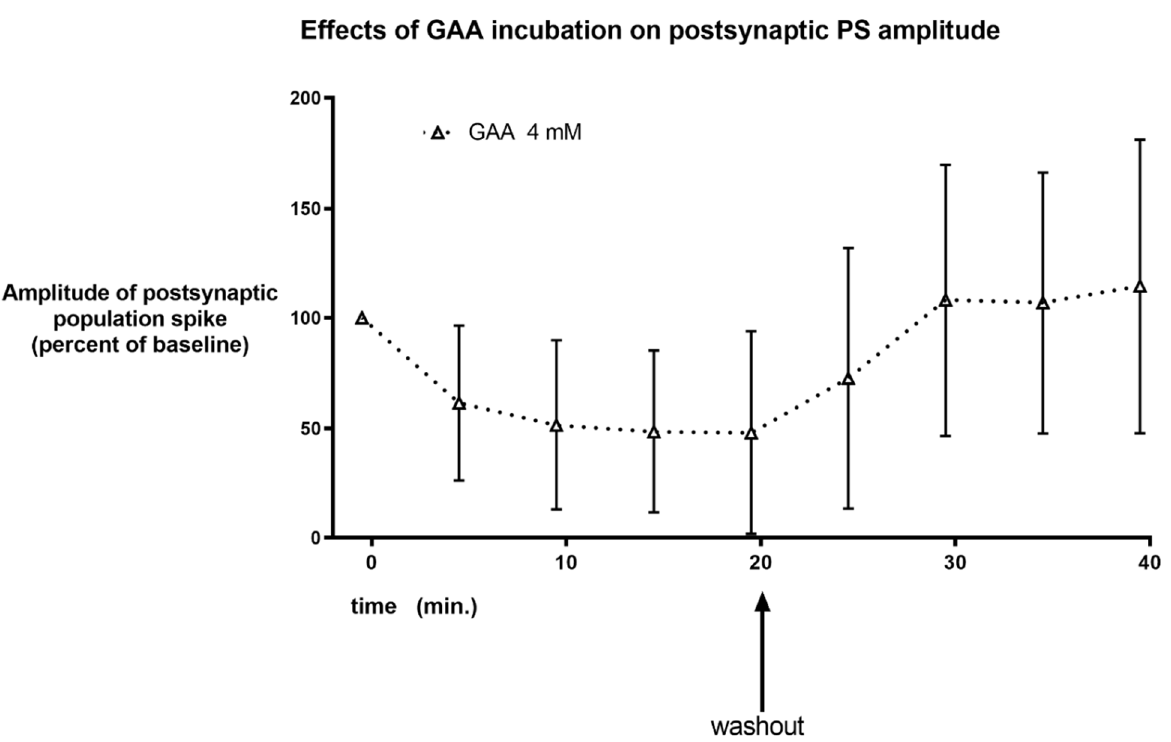
Figure 6. Same parameters and graph as in Figures 4 and 5, using the concentration of 4 mM. A decrease in population spike amplitude is observed that was reversible upon washout and statistically significant ( p = 0.0454, repeated measures analysis of variance). Incubation of brain slices with 2 mM GAA caused a significant increase in both crea- tine and phosphocreatine in the tissue. As expected, such an increase did not occur after